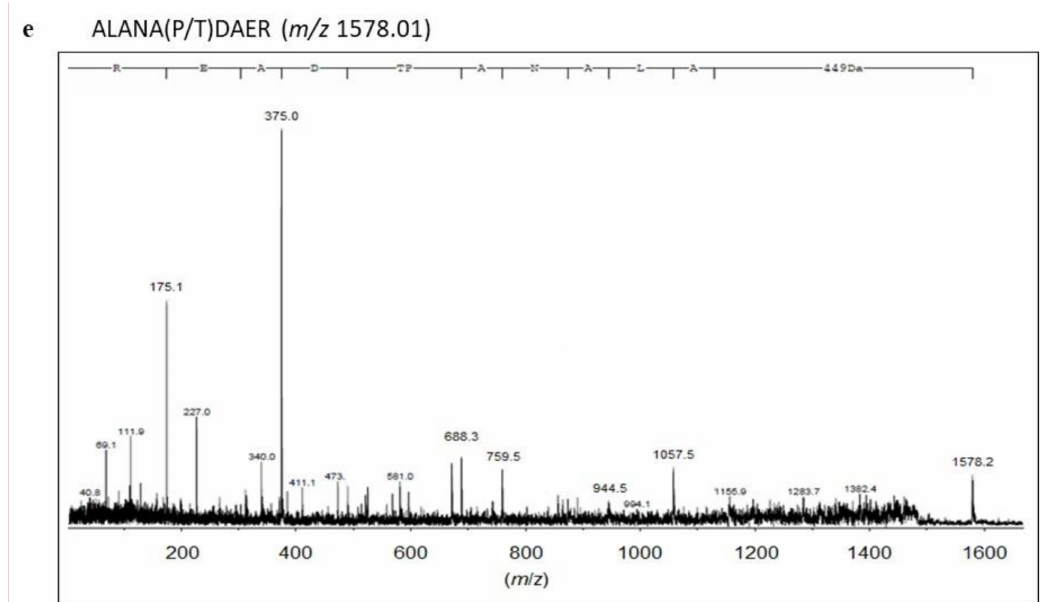
Figure 3. Identification of SM deacylase from rat skin. ( a ) MALDI-TOF-MS spectra from digested protein separated by 2D-PAGE; the x-axis represents the mass-to-charge ratio ( m / z ) whereas the y-axis represents relative abundance. ( b – e ) MS / MS spectrum of tryptic peptides from the SM deacylase active protein spot. Peptide sequences of ionic peaks obtained in ( a ) were analyzed according to their intensity and four peptide sequences were identified. Representative peptide fragmentation patterns are shown (( b ): SLLTEDGQGNLLNGR, m / z 1885.18 / ( c ): WVGFLTR ( m / z 1191.7) / ( d ): LGLVTTPFAR ( m / z 1411.0) / ( e ): ALANA(P / T)DAER ( m / z 1578.0)) with y-series ions. The peptide (SLLTEDGQGNLLNGR) and another peptide (WVGFLTR) revealed a part of aCDase when referring to the MASCOT